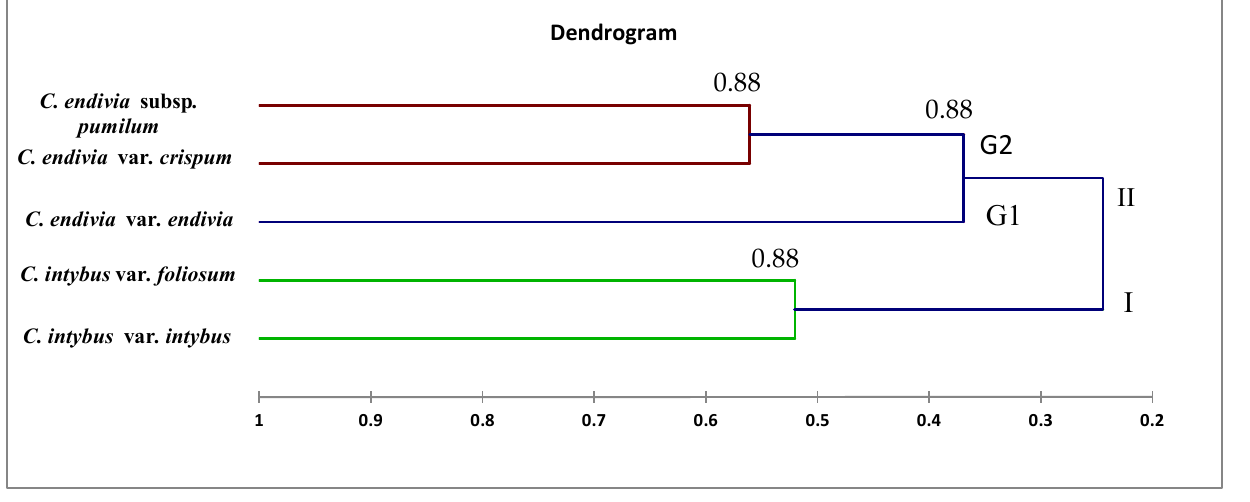
Figure 10. Dendrogram of the relationships between the five taxa of Cichorium based on the combined morphological and molecular characters using UPGMA analysis.